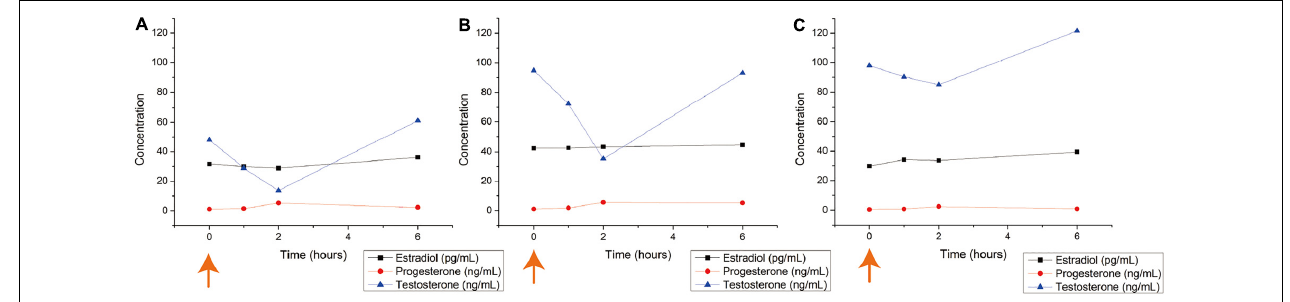
FIGURE 2 | Blood hormone level changes after Ovaprim R (cid:13) injection in male Triakis scyllium . Ovaprim R (cid:13) was injected intramuscularly into the epaxial muscle. (A) Average hormone concentration changes of Group A (0.1 mL/kg). (B) Average hormone concentration changes of Group B (0.2 mL/kg). (C) Average hormone concentration changes of Group C (0.4 mL/kg). The orange arrows indicate the time points of Ovaprim R (cid:13) injection.